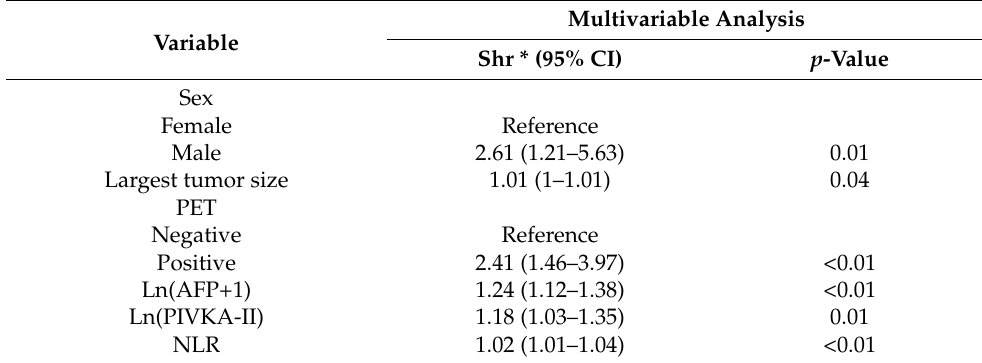
Table 2. Risk factors for HCC-specific